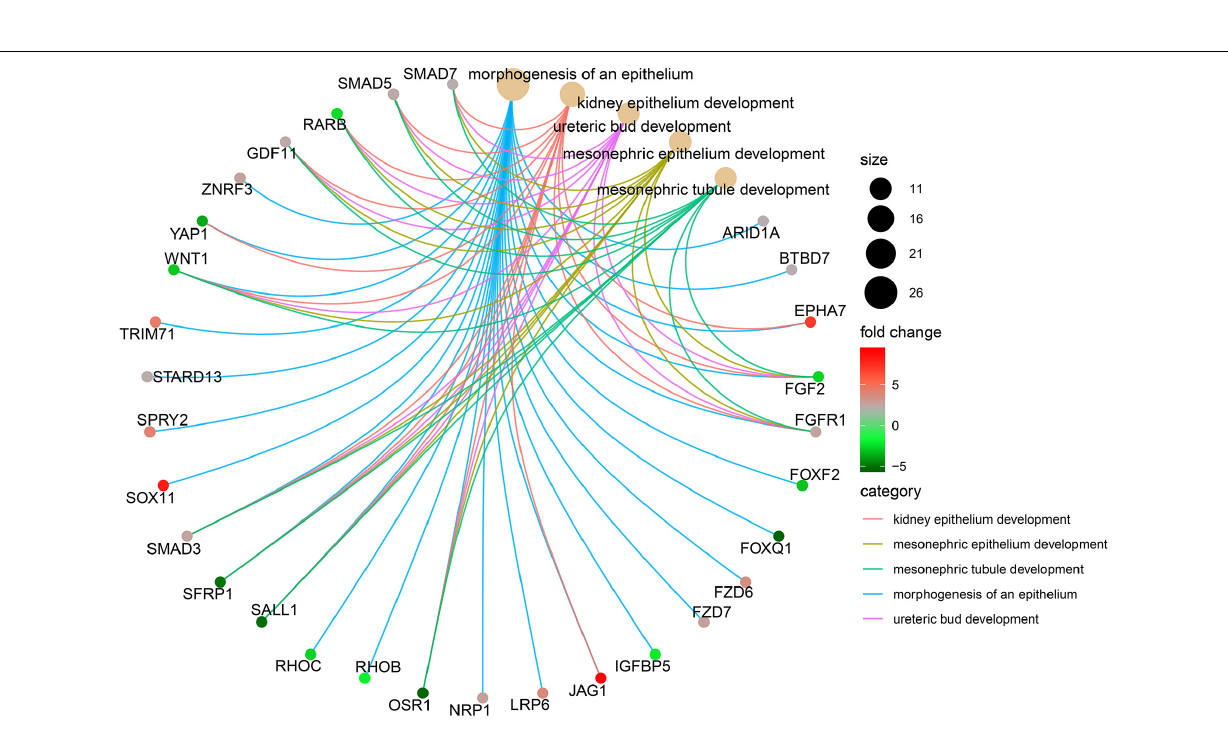
Frontiers in Genetics |